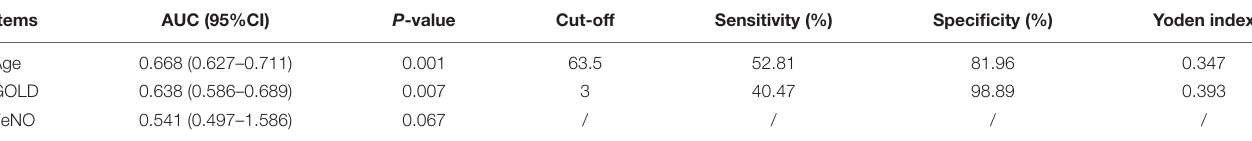
TABLE 3 | Efficacy analysis of each indicator at the 30-day follow-up. Items AUC (95%CI) P -value